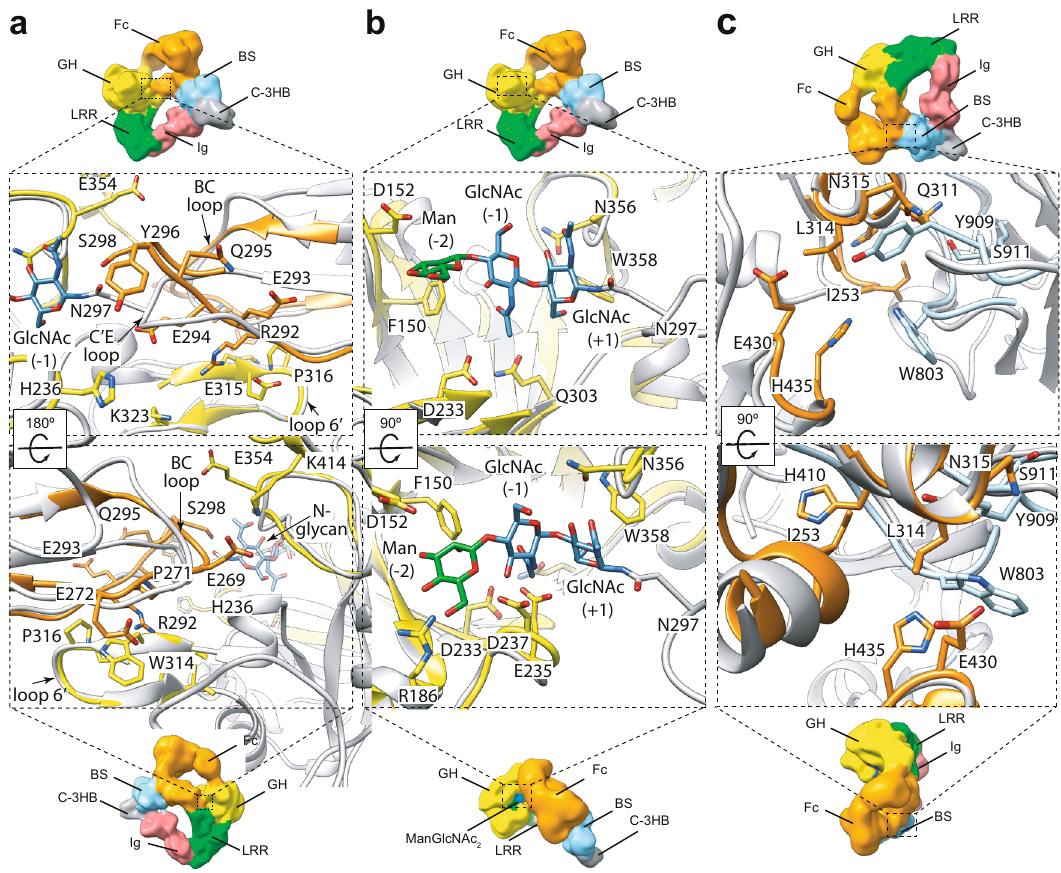
Fig. 2 | The Fc binding site of EndoS. In order to have insights on the possible location of the side chain residues that could be involved in the enzyme-substrate interactions, we locally compared/superimposed the high-resolution EndoS (PDB code 6EN3; yellow) and Fc region (PDB code 2DTS; orange) crystal structures with our EndoS E235A -Fc cryoEM structure (gray; Methods section). Therefore, we visua- lize potential side chain interactions between residues that are within interaction